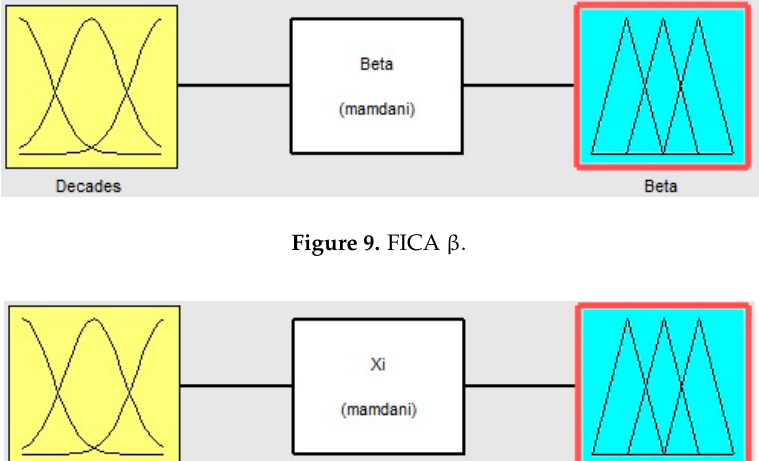
Figure 10. FICA ξ .